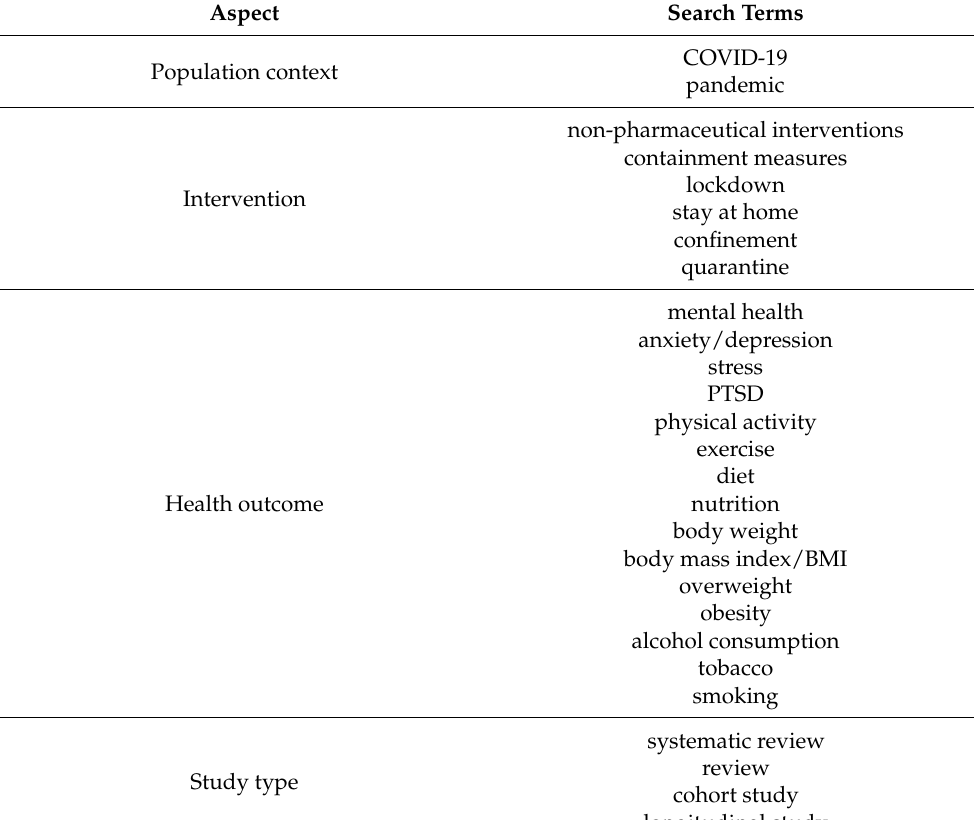
Table 1. Search terms of relevance to the two main research